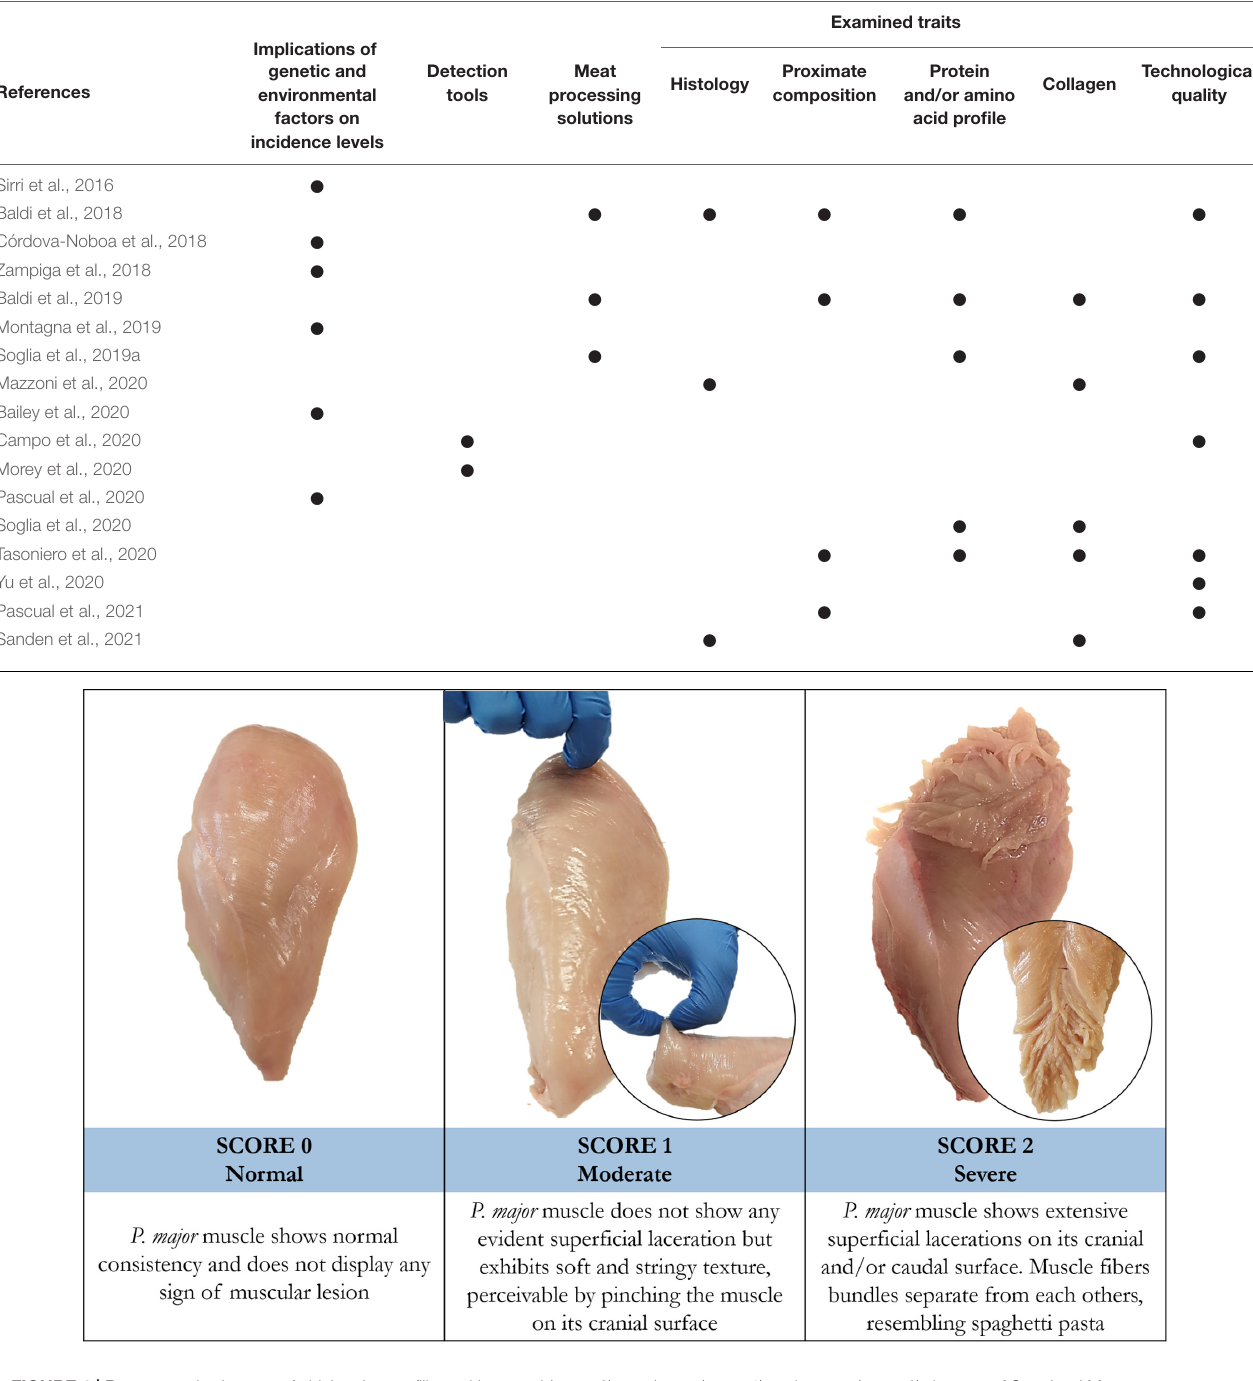
TABLE 1 | Chronological sequence of available published studies concerning spaghetti meat condition and relative addressed topics.